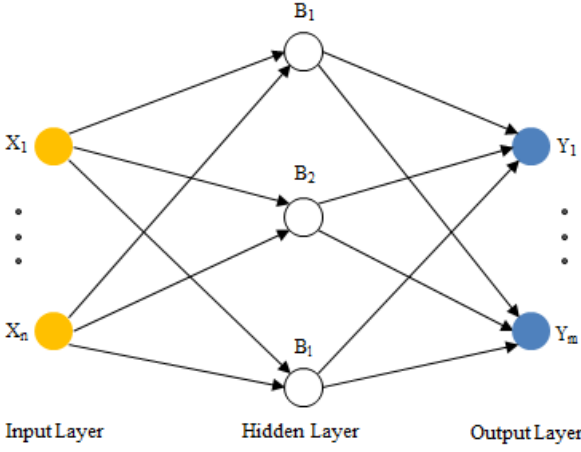
Figure 2. Single hidden layer feed-forward neural network called ELM.